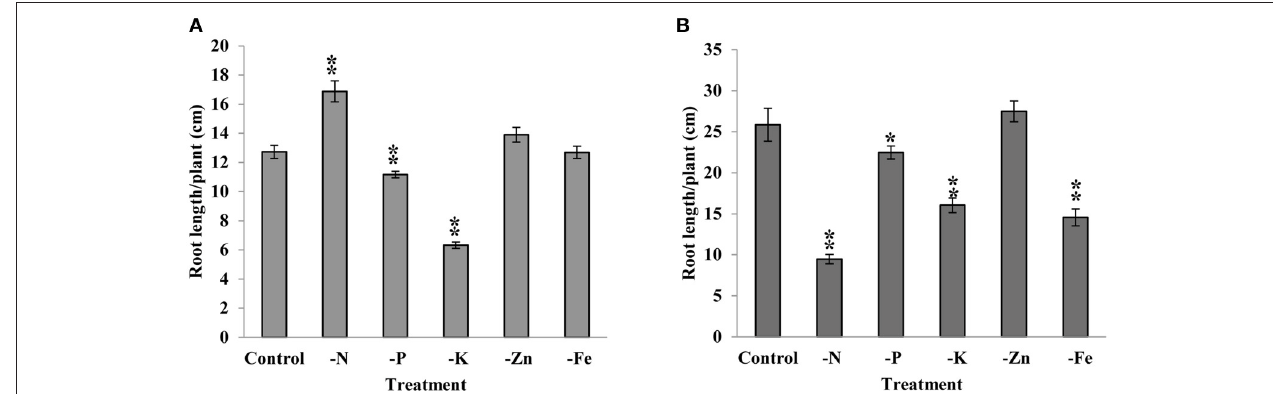
FIGURE 6 | Root length of rice (A) and Chickpea (B) under different nutrient stresses recorded after 15 days of treatment. Length of longest root was used for measurement. Each bar represents the average of 20 plants/treatment with standard error. “ * ” indicates p -values.